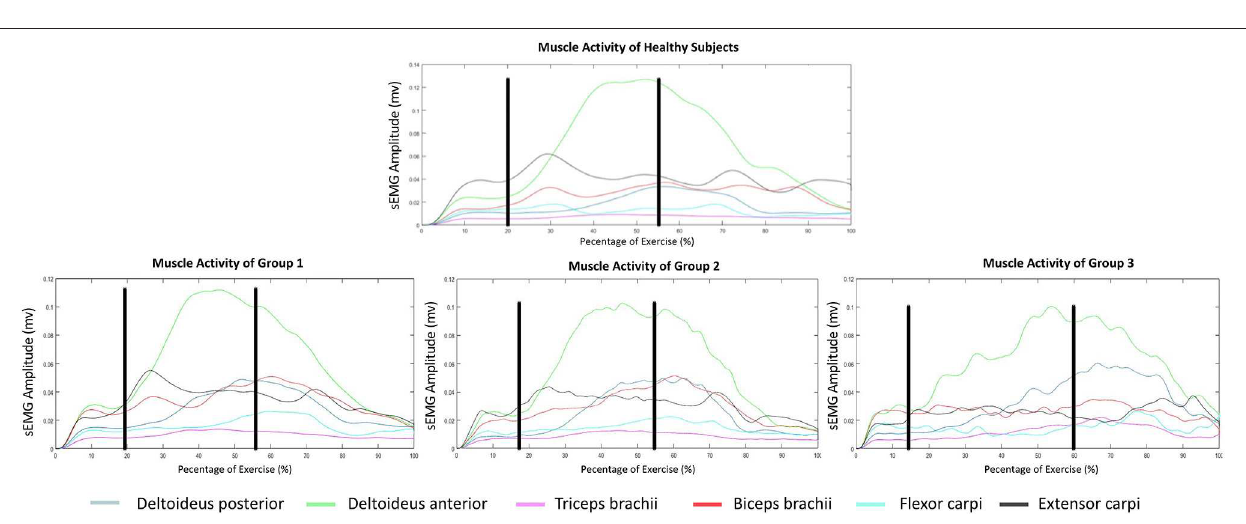
FIGURE 3 | Mean surface sEMG envelope of healthy subjects (Top) and patients (Bottom)